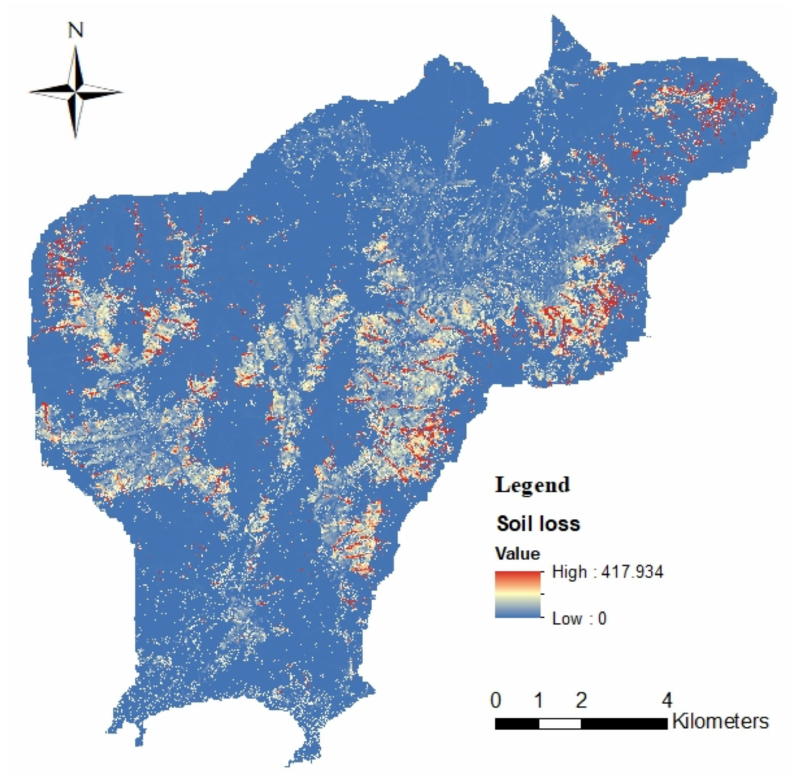
Figure 15. Soil loss map produced using R from the Global Precipitation Measurements (GPM) and C from the literature data.